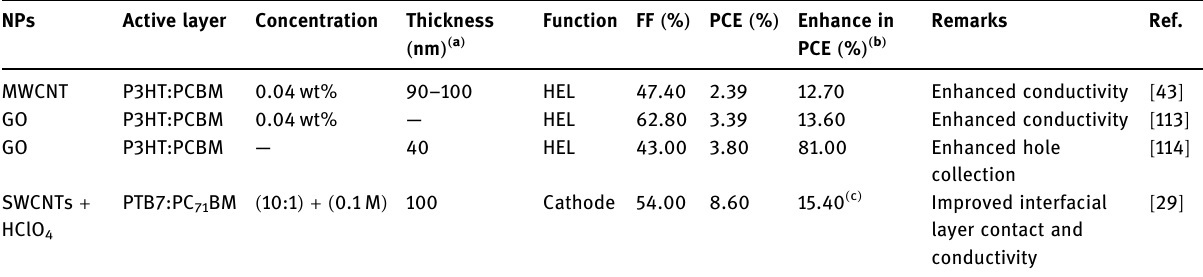
Table 8: Device characteristics of OPVs with carbon - based NPs doped PEDOT:PSS NPs Active layer